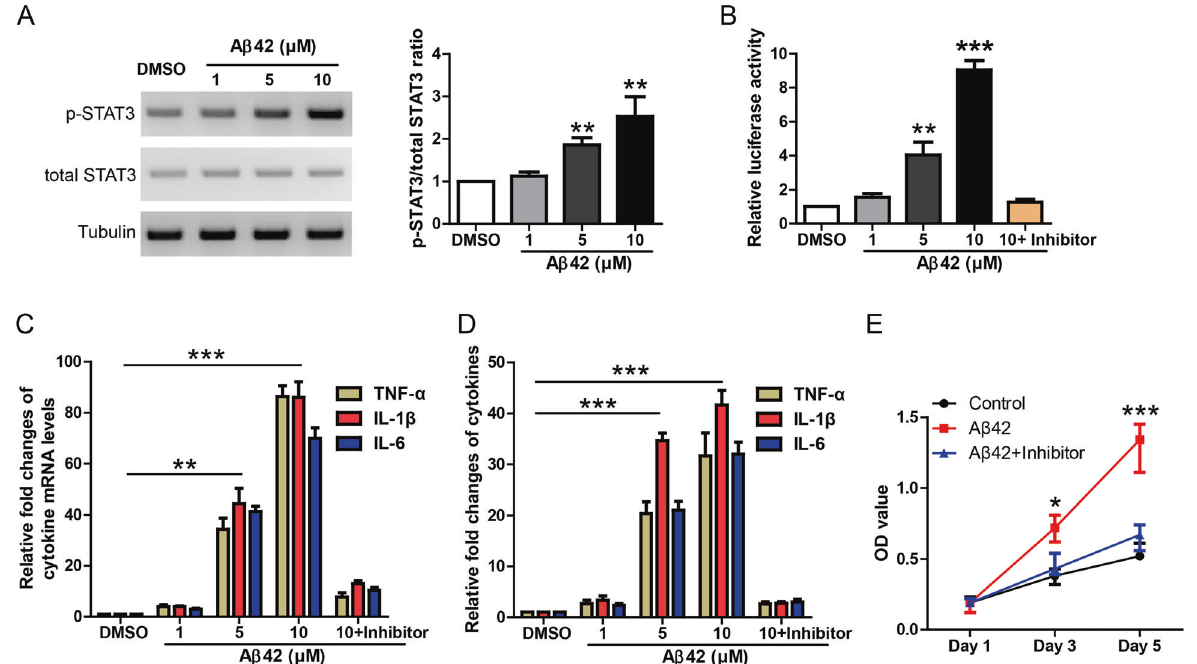
Fig. 1 A β 42 induces STAT3-dependent in fl ammation responses in primary astrocyte culture. A Western blot and its quanti fi cation showing STAT3 protein levels in astrocyte culture treated by A β 42 at indicated concentrations. B STAT3 luciferase reporter assay showing STAT3 transcription activity in astrocyte culture treated by A β 42 at indicated concentrations and STAT3 inhibitor. C Quantitative real-time PCR results showing the levels of TNF- α , IL-1 β , and IL-6 in the astrocyte culture treated by A β 42 at indicated concentrations and STAT3 inhibitor. D ELISA results showing the levels of TNF- α , IL-1 β , and IL-6 in the astrocyte supernatant under the treatment of A β 42 at indicated concentrations and STAT3 inhibitor. E CCK-8 assay showing the astrocyte proliferation under the treatment of A β 42 at indicated concentrations and STAT3 inhibitor. * P < 0.05, ** P < 0.01, *** P <